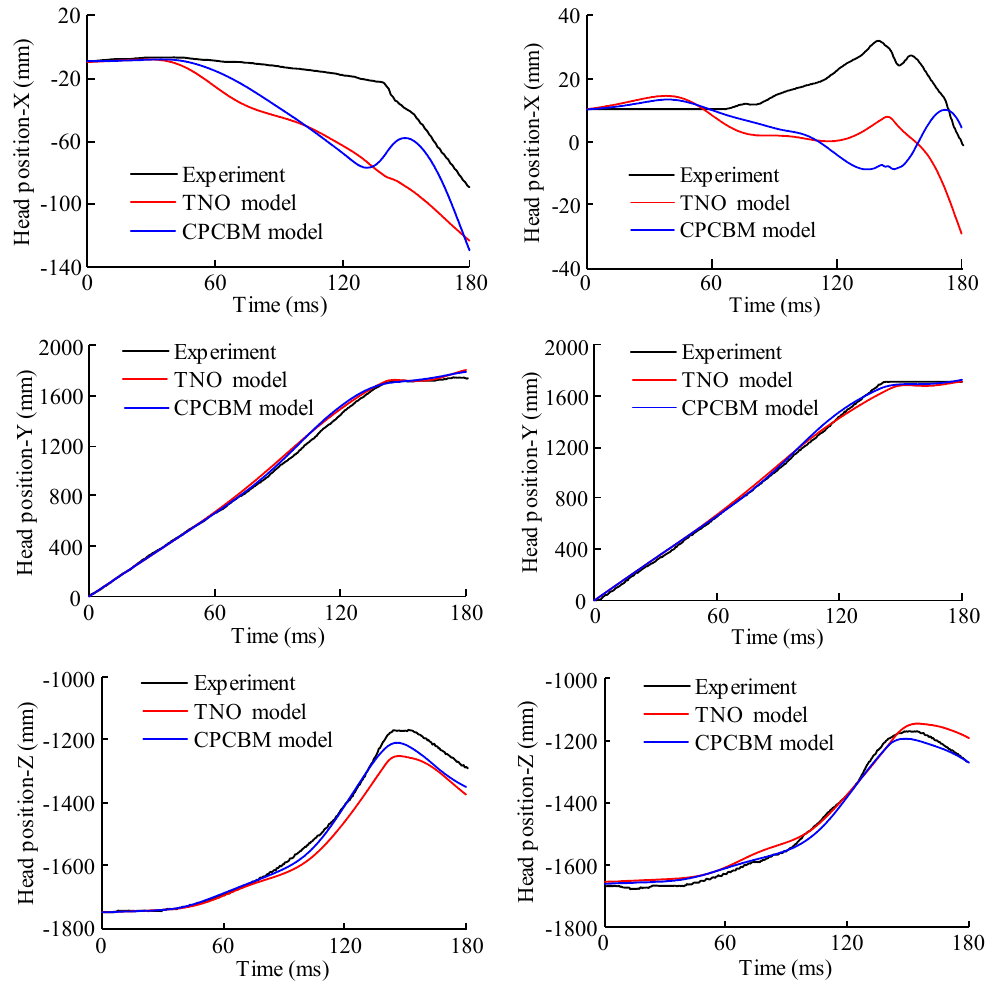
Figure A8. The displacement of the head COG in the X/Y/Z directions for test V2371 (left) and test V2374 (right).